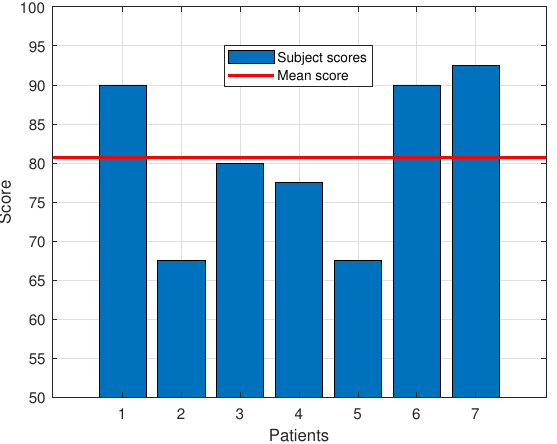
Figure 7. SUS score for each patient along with the mean score.